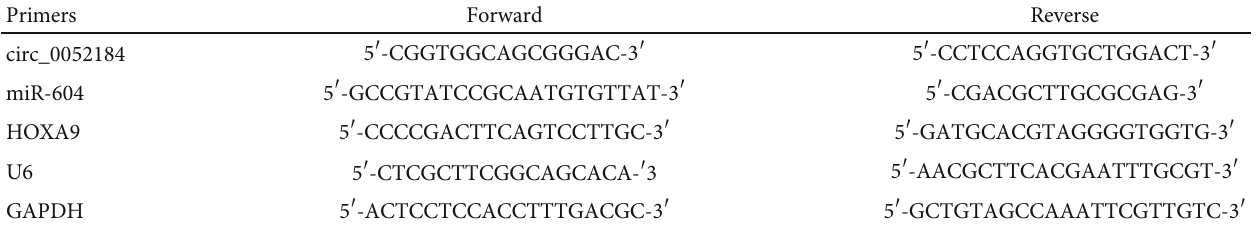
Table 1: Primers for circ_0052184, miR-604, and HOXA9.